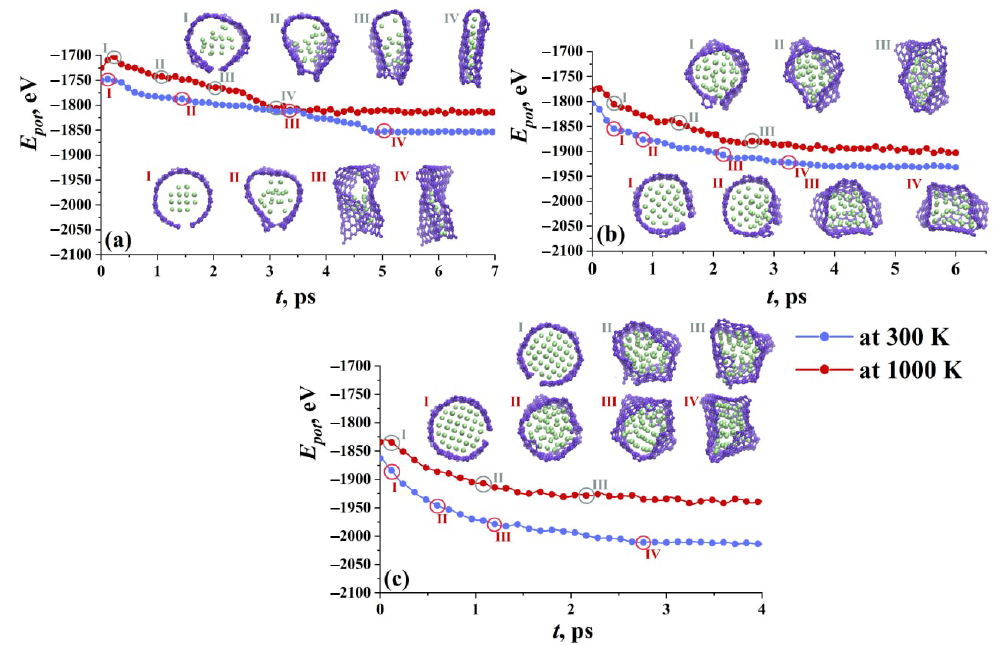
Figure 8. Potential energy as the function of exposure time for graphene flake with different nanopar- ticles Ni21 ( a ), Ni47 ( b ), and Ni66 ( c ). The snapshots of GF filled with nanoparticles are presented for 300 K (upper snapshots) and 1000 K (lower snapshots). Carbon atoms are shown in violet and nickel atoms are shown in green. Reprinted with permission from